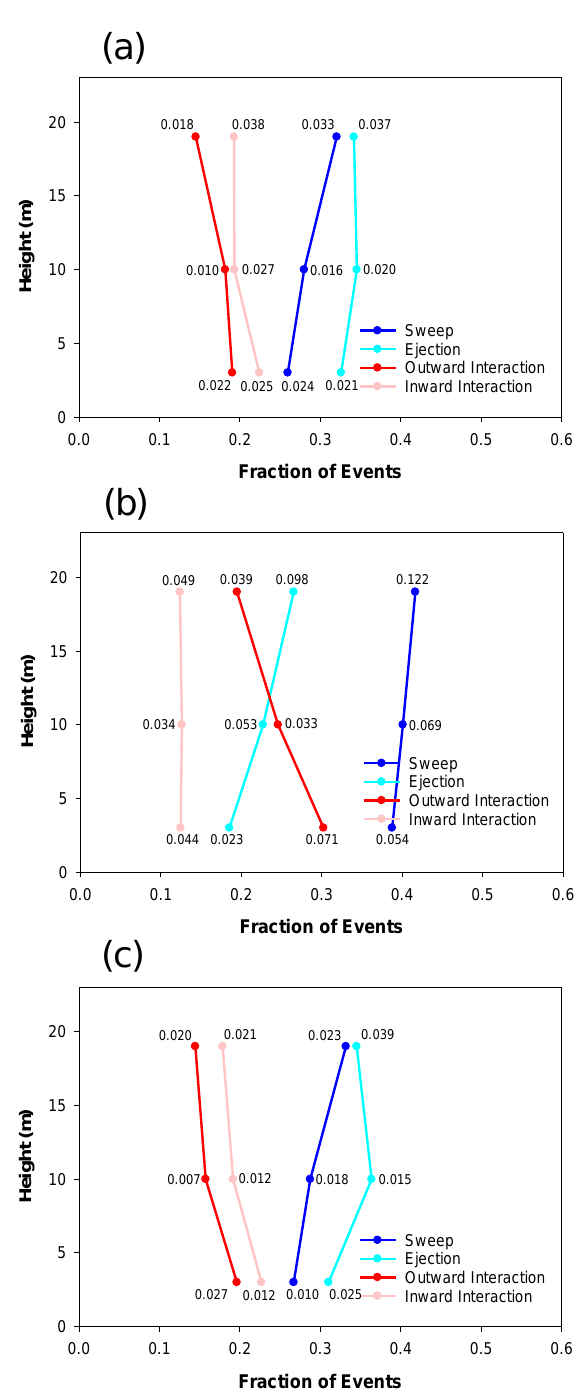
Figure 6. Mean fractional number of sweep, ejection, outward interaction, and inward interaction events during the ( a ) pre-FFP, ( b ) FFP, and ( c ) post-FFP periods at 3 m, 10 m, and 19 m AGL, computed from all five in situ towers. Numbers adjacent to the data points indicate standard deviations.